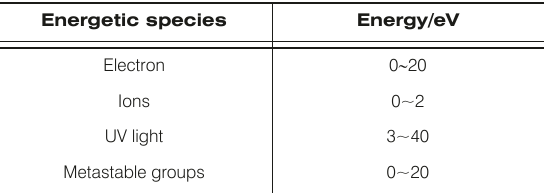
Table 2. The energy of the energetic species in GDEP. Energetic